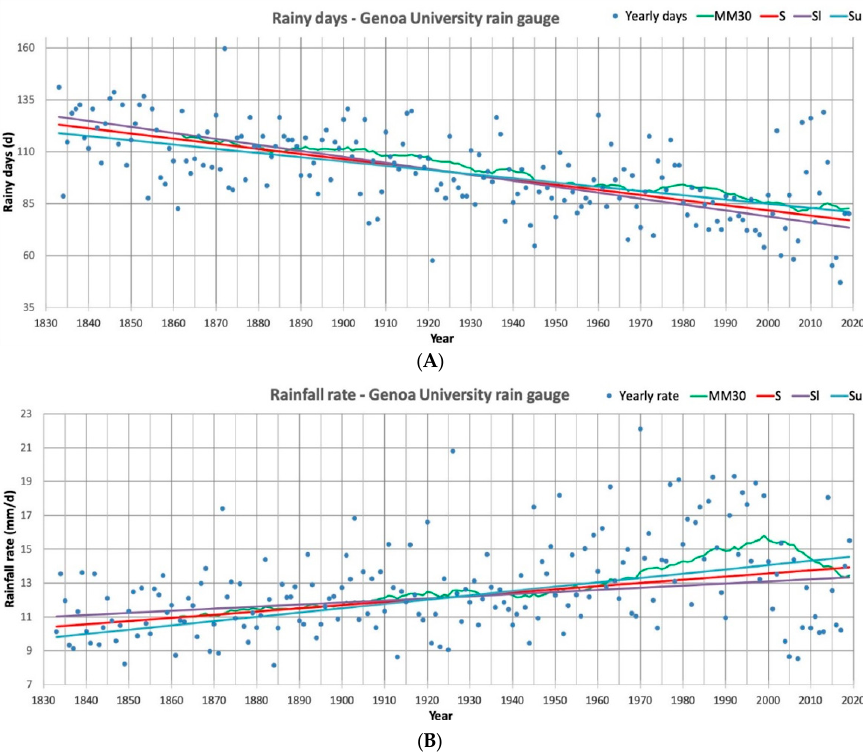
Figure 11. Rainy days ( A ) and rainfall rate ( B ) series scatterplot for Genoa University rain gauge (1833–2019); MM30: mean mobile at 30 years; S: Sen’s trend line; Sl: Sen’s lower confidence (95%) slope; Su: Sen’s upper confidence (95%) slope.